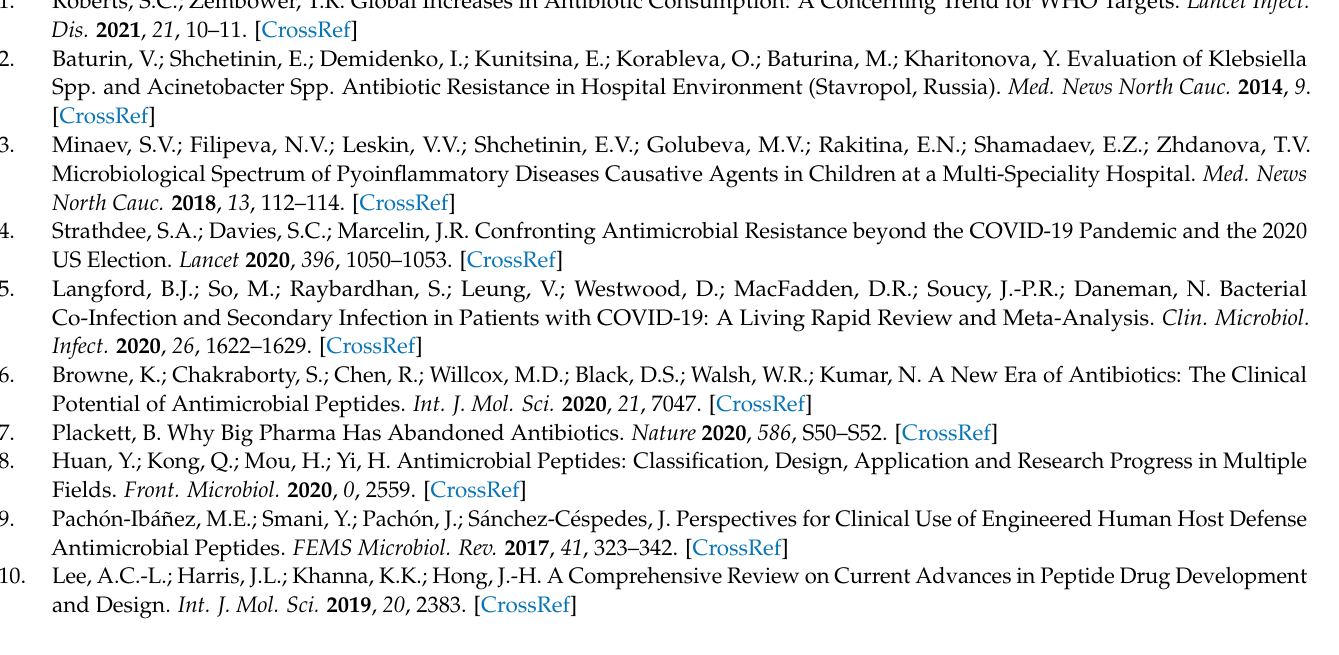
vs. PEP-36.; Figure S2: Probability of survival: control vs. PEP-38; Figure S3: Probability of survival: control vs. PEP-137; Figure S4: Time evolution of root mean squared deviation of peptides and membrane throughout the MD simulation; Figure S5: Percentage of hydrogen bonding between peptide residues and membrane averaged over the last 50ns; Table S1: MIC values calculations against K. aerogenes ; Table S2: MIC values calculations against K. pneumoniae ; Table S3: MIC values calculations against P. aeruginosa ; Table S4: Survival proportions in all experimental animal groups; Additional files: Training dataset.csv; Sampled peptides.csv; PDB files of PEP-36, PEP-38 and PEP-137 predicted by AlphaFold